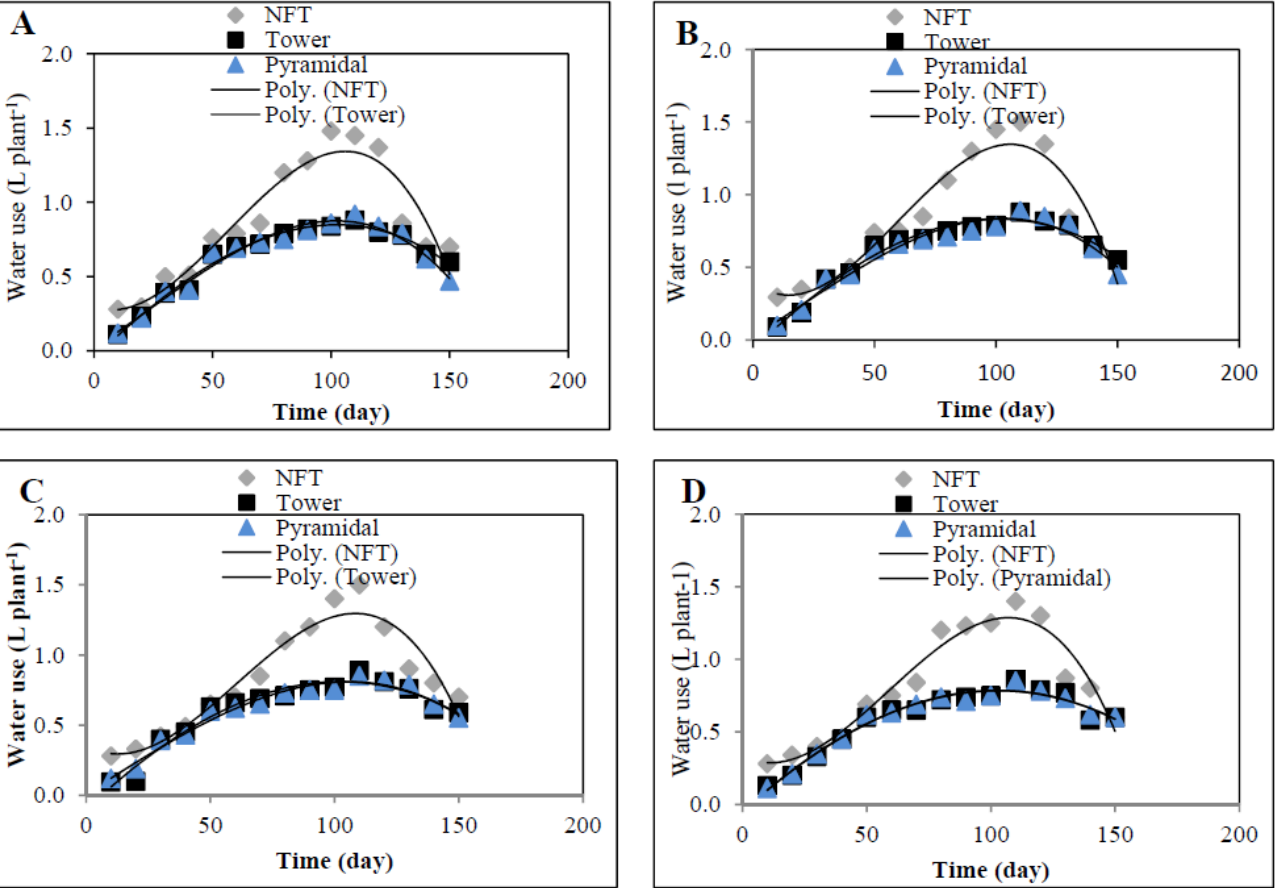
Figure 3. The daily water consumption of different stages (each stage 10 days) for different soilless culture systems under normal and magnetic water along with cultivation period. ( A ) is water use in the case of the control (without using any magnetic treatment). ( B ) is water use in the case of MWL 1. ( C ) is water use in the case of MWL 2. ( D ) is water use in the case of MWL 3.